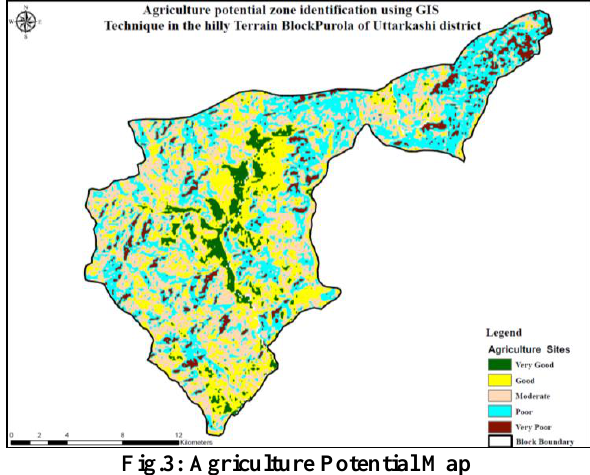
Fig.3: Agriculture Potential